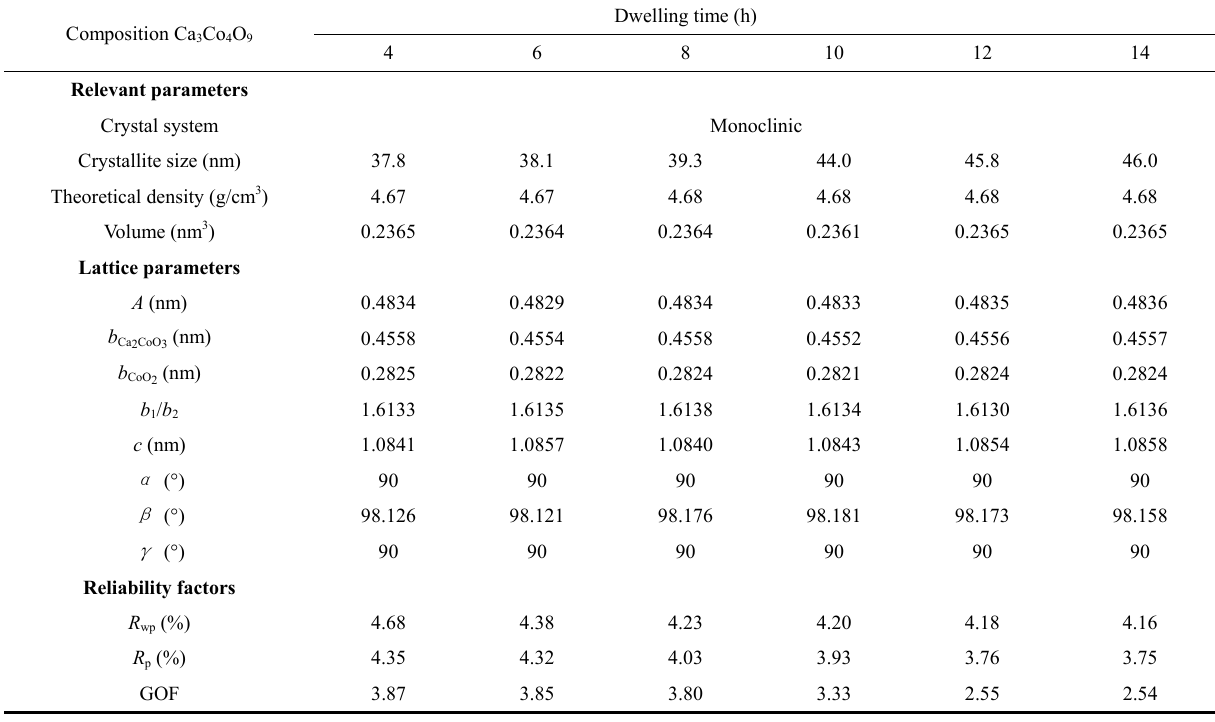
Table 1 Relevant parameters and reliability factors of Ca 3 Co 4 O 9 powder from XRD results calcinated at temperature 1073 K with different dwelling time (4, 6, 8, 10, 12, and 14